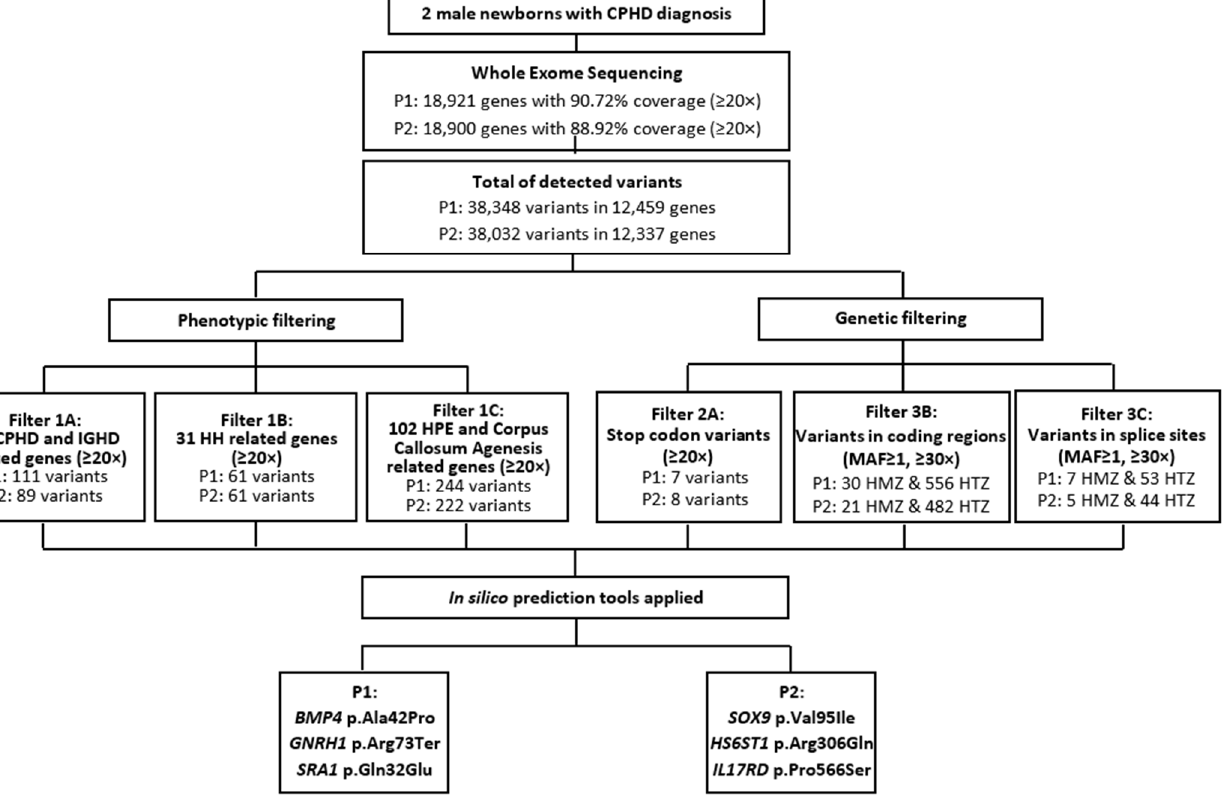
Figure 1. NGS analysis pipeline and filtering. Abbreviations: P1 = Patient 1; P2 = Patient 2; MAF = Minor Allele Frequency; HMZ = homozygous; HTZ = heterozygous; CPHD = Combined Pituitary Hormone Deficiency, IGHD = Isolated Growth Hormone Deficiency, HH = Hypogonadotropic Hypogonadism, HPE = Holoprosencephaly.